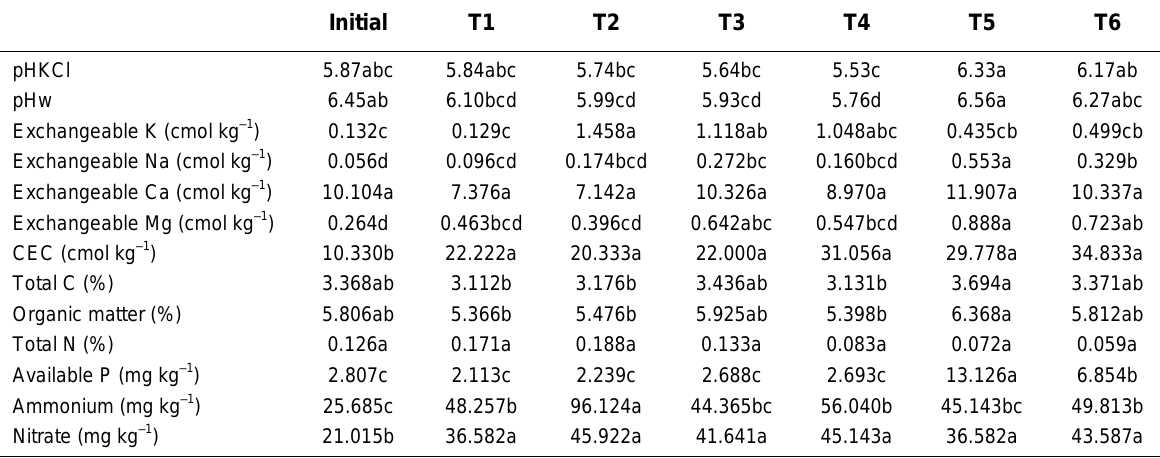
Soil Selected Chemical Characteristics at 57 DAS